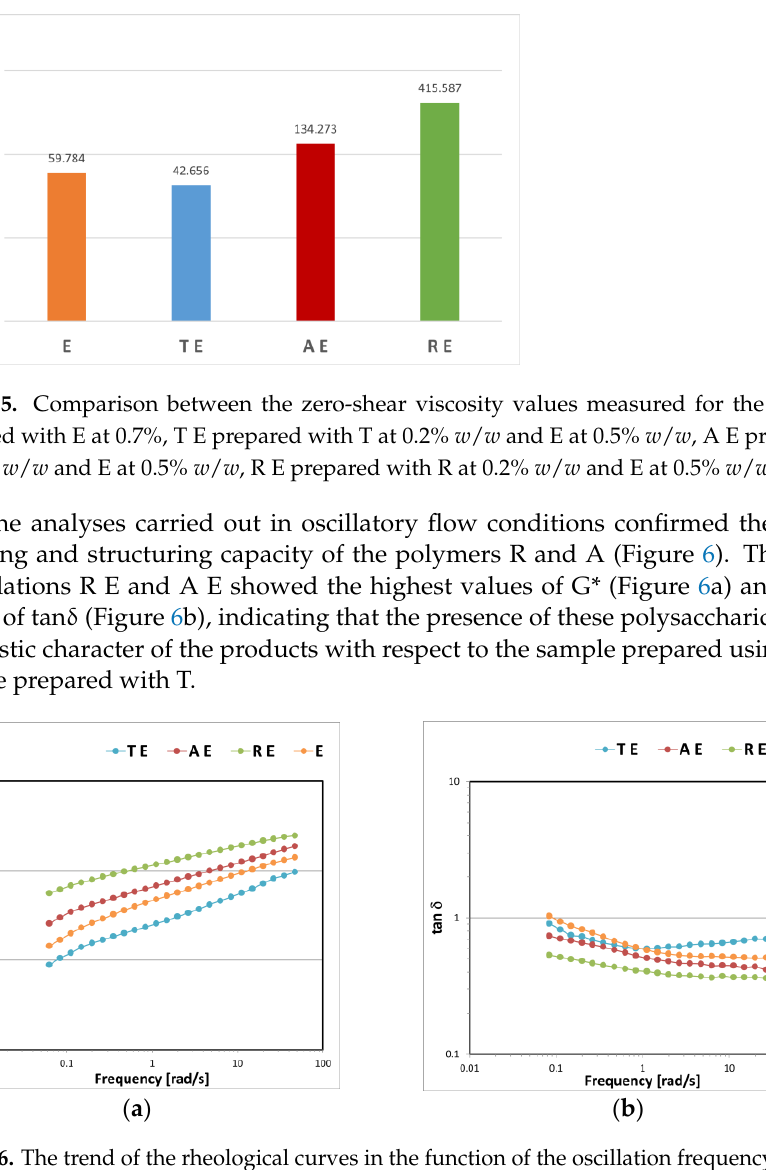
Figure 7. Texture curves obtained from an immersion/de-immersion test performed on the gel – creams E prepared with E at 0.7%, T E prepared with T at 0.2% w / w and E at 0.5% w / w , A E prepared with A at 0.2% w / w and E at 0.5% w / w , R E prepared with R at 0.2% w / w and E at 0.5% w / w . After adding the plant-based active PFP at 3% w / w to the gel – creams formulations, some structural modifications could be seen (Figure 8). The tanδ values of the formulation T E were higher than the other gel – creams and became even higher when the active was added, confirming the liquid-viscous properties of the T polymer (Figure 8a). For the for- mulations A E and R E there was no significative variation of tanδ after the insertio n of PFP. However, a slight decrease in the firmness was detected for all the samples in the presence of PFP, thus, indicating a greater spreadability (Figure 8b). All these samples were stable during the centrifuge test.